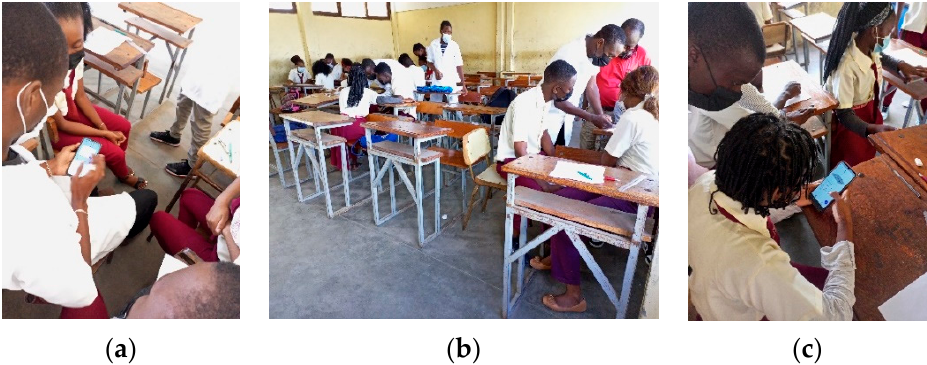
Figure 8. Simulated exercises in GeoGebra. ( a – c ) Environment of the groups handling GeoGebra on the smartphone.